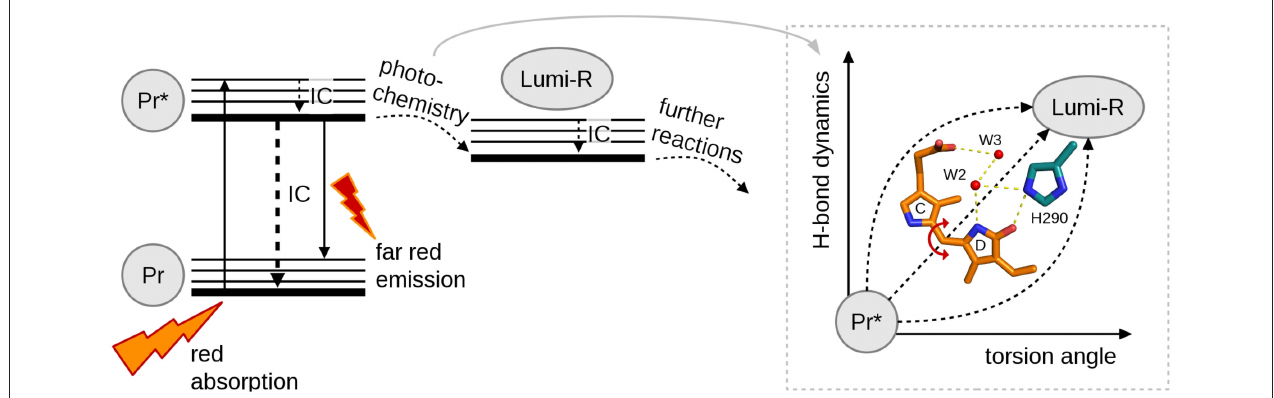
FIGURE 3 | A simplified reaction diagram showing the excitation of molecule with red light from Pr ground state to its singlet excited state (Pr * ) followed by internal conversion (IC), fluorescence or photochemistry. Pr * relaxes back to the ground state by IC or far-red fluorescence. For photochemistry at least two coordinates are needed to describe the complete reaction, torsion angle and H-bond